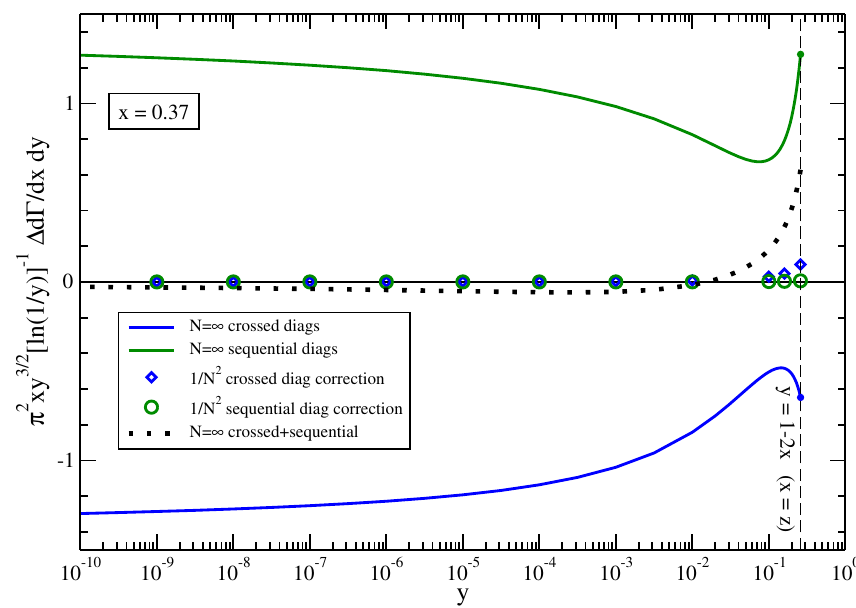
Figure 19 . A plot for x = 0 . 37 of the y dependence of the different contributions to ∆ d Γ /dx dy , multiplied by π 2 xy 3 / 2 and then divided by ln( y − 1 ) . The dotted line shows the to- tal crossed+sequential N = ∞ result, corresponding to the solid curve in figure 18. Note that the vertical axis is normalized differently here than in figure 18, but still presented in units of p Nα s ˆ q A /E . [The intended purpose of this plot is qualitative. See figure 20 if interested in the precise values corresponding to the 1 /N 2 data points.]